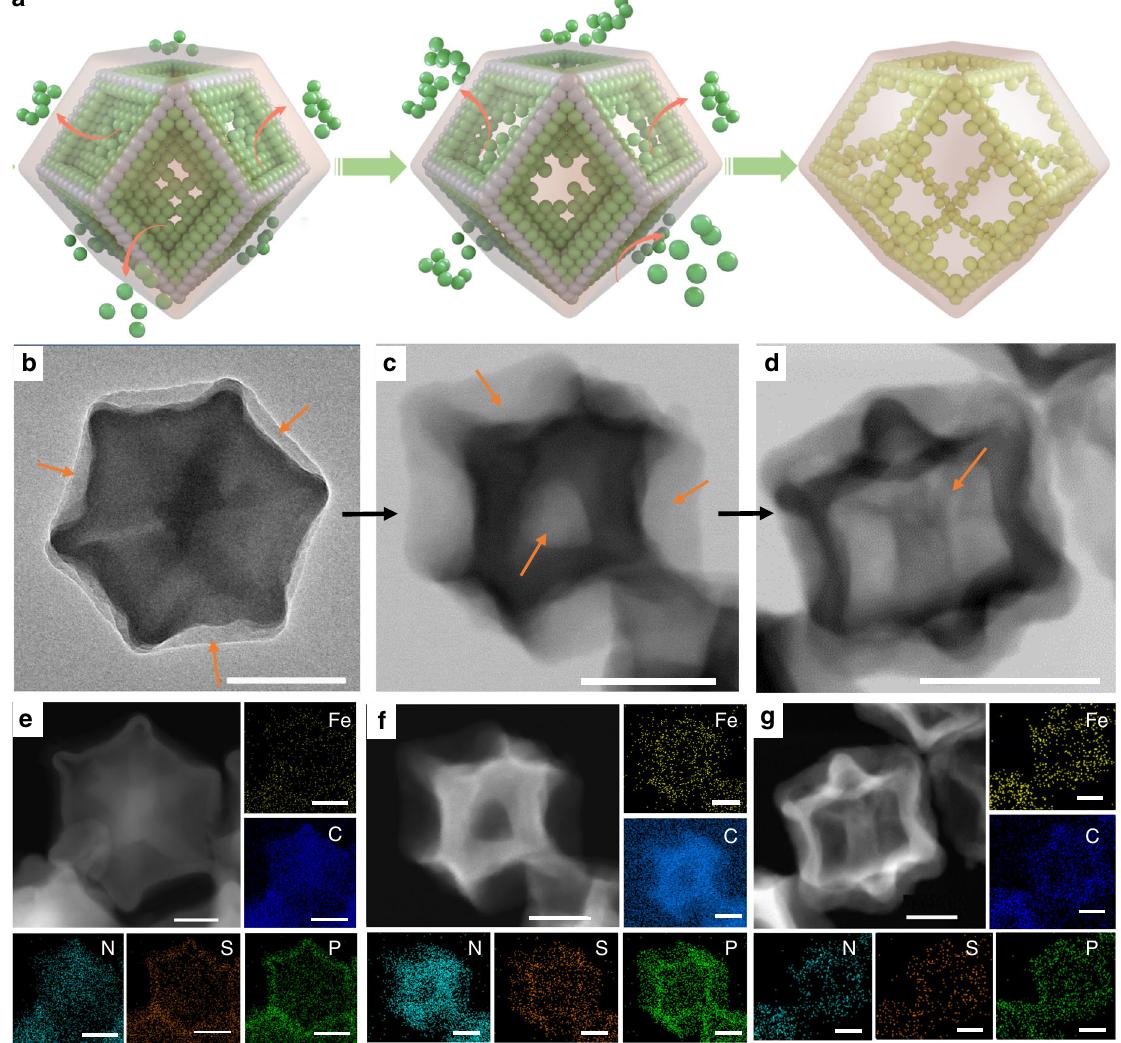
Fig. 2 The formation process of functionalized hollow structure. a Schematic illustration of evolutionary trajectory of hollow structure. b – d Transmission electron microscopy (TEM) images, scale bar, 200 nm; and e – g the corresponding energy-dispersive spectroscopy (EDS) element maps (Fe: yellow, C: blue, N: cyan, S: orange, P: green) at different pyrolysis temperatures of 400, 500, and 600 °C for 30 min with a heating rate of 5 °C min − 1 under fl owing Ar atmosphere, respectively, scale bar: 100